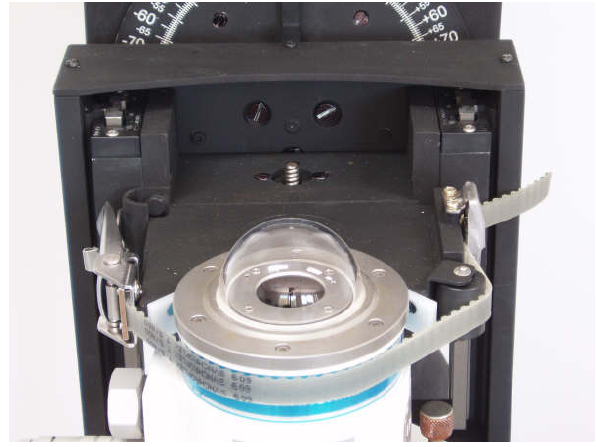
Figure 6. Detail of the system to fasten the radiometer under test on to the automatic